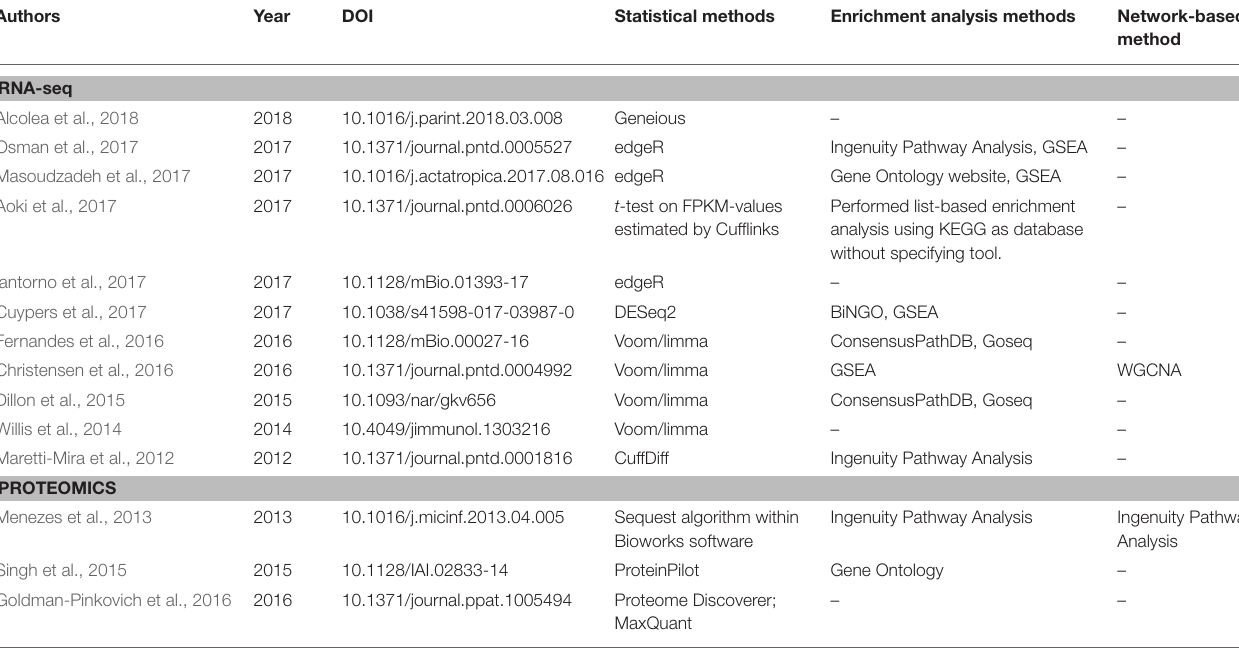
TABLE 2 | Statistical and bioinformatics analyses performed in published articles in the leishmaniasis field that employed RNA-seq and proteomics